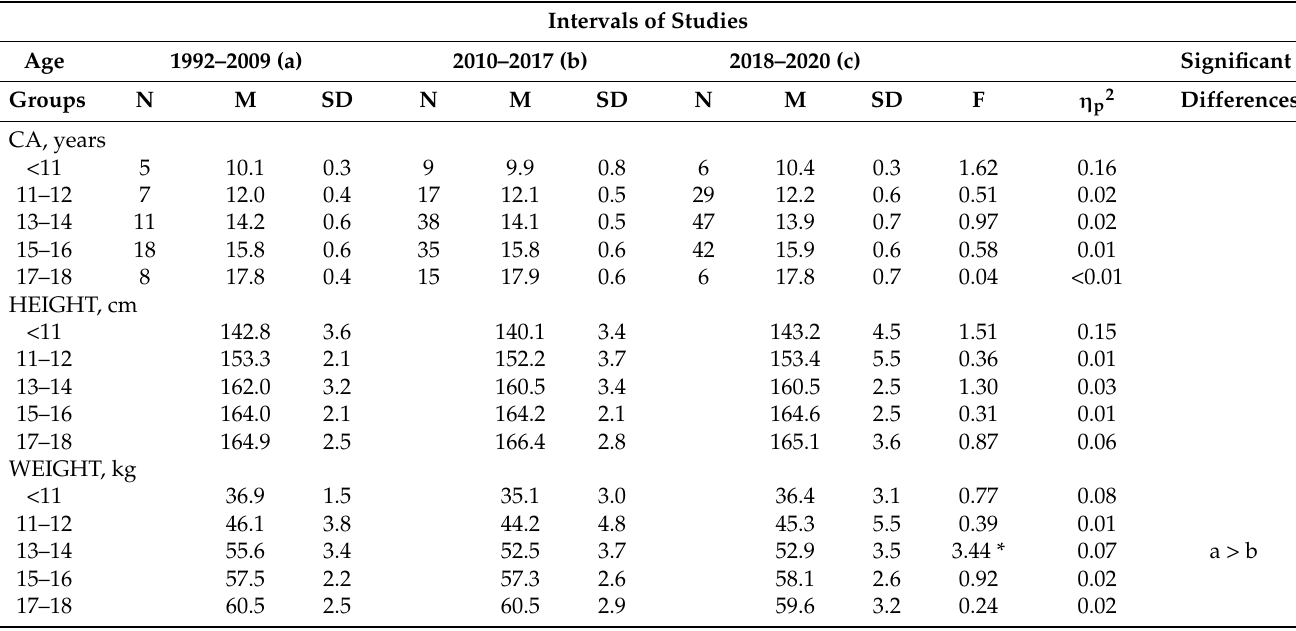
Table 1. Number of data points (N) † , means (M) and standard deviations (SD) based on the means for chronological age (CA), height and weight of female soccer players by two-year age groups in studies spanning three intervals, 1992 to 2009, 2010 to 2017 and 2018 to 2020, and results of ANOVAs and effect sizes ( η p2 ). Intervals of Studies